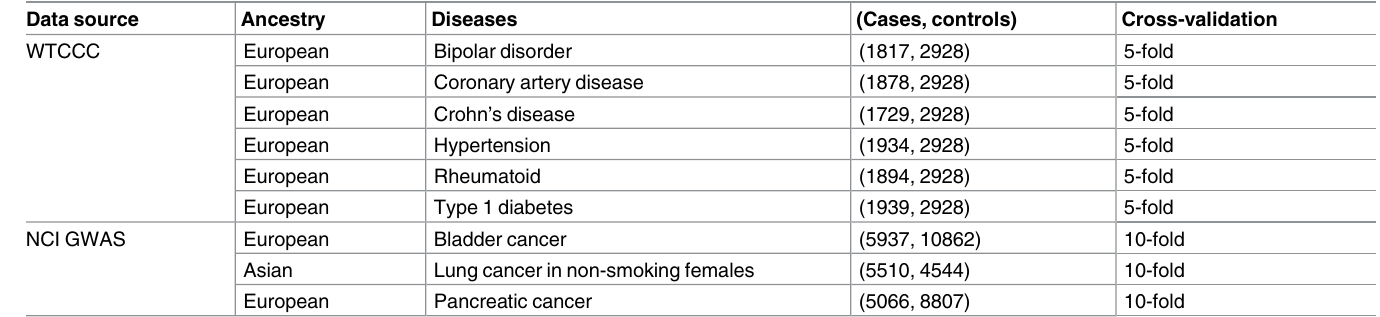
Table 1. GWAS data sets with individual level data.